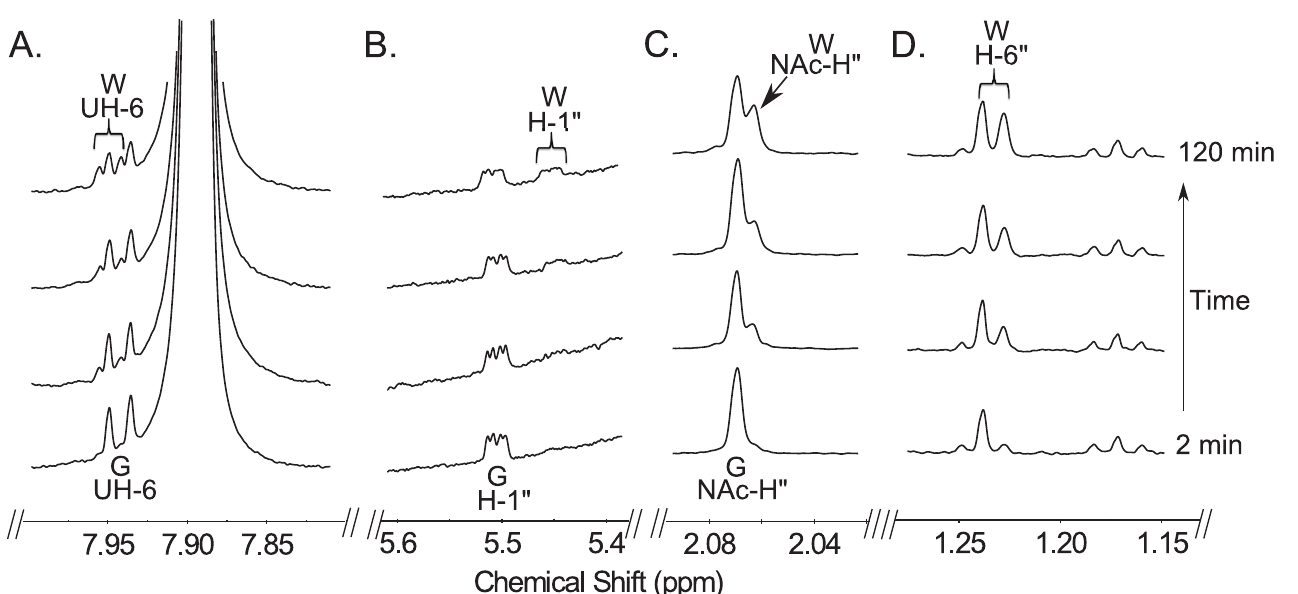
Fig 5. Time-resolved 1 H-NMR analysis of Pdeg reaction showing the conversion of UDP-GlcNAc to hydrated-4-keto-UDP-suagr. Spectra were collected for the first 120 min of the reaction that was conducted at 25°C and included Pdeg and 1 mM of UDP-GlcNAc (time 0). Four selected regions of